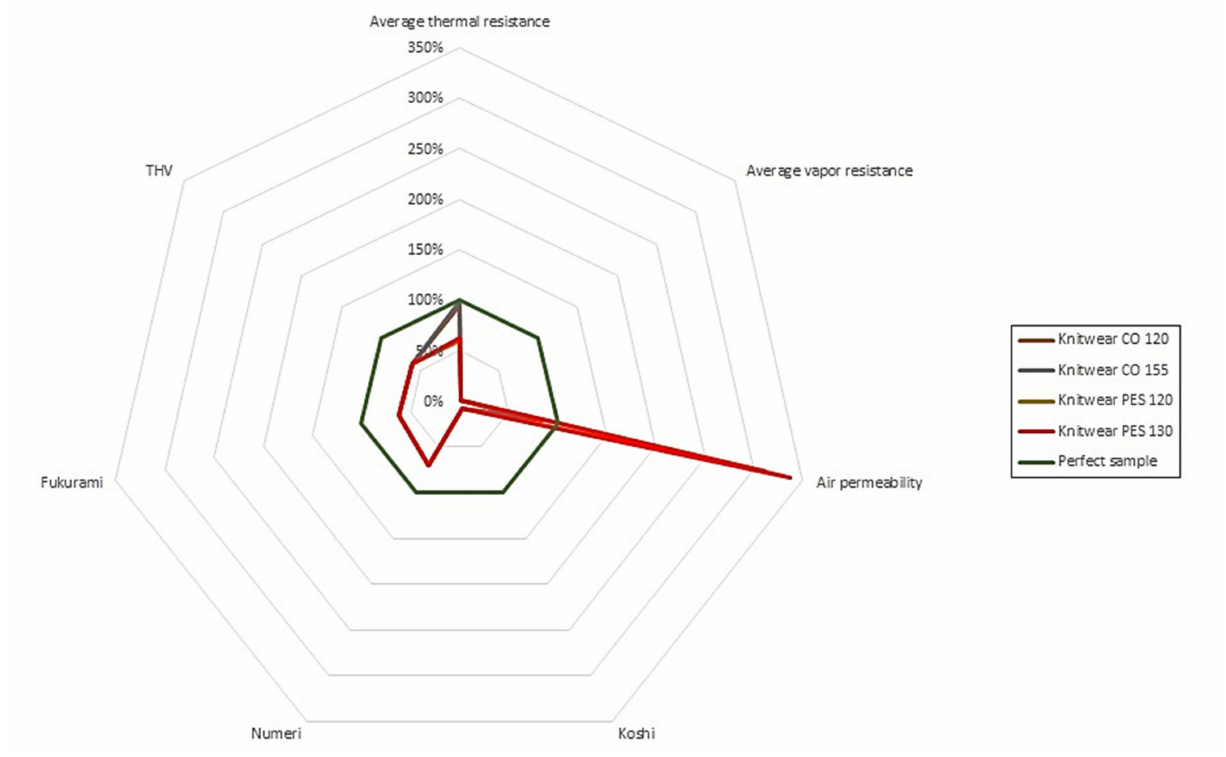
Figure 15. Sensory and biophysical properties of knitted